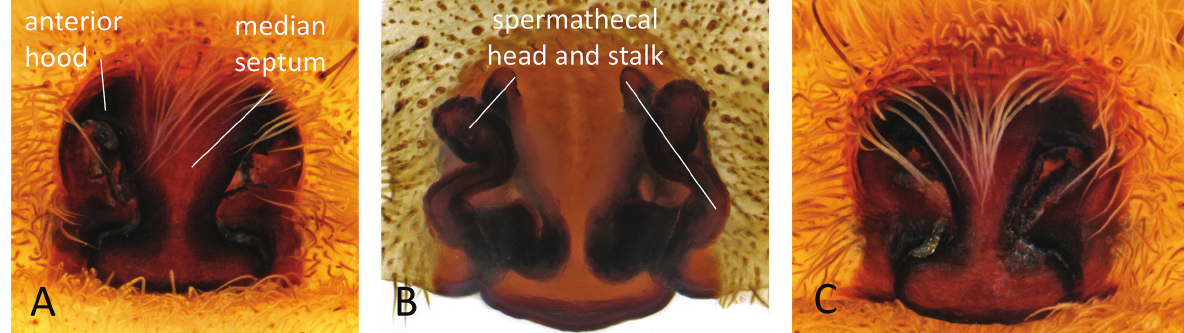
Figure 4. Portacosa cinerea gen. n. and sp. n., female paratype (WAM T53550) and non-type female from Runnymede Flora Re- serve, Victoria (WAM T56072). A, B, female paratype, epigyne in ventral ( A ) and dorsal ( B ) view, C, non-type female, epigyne, ventral view. Scale bar: A, B, C –